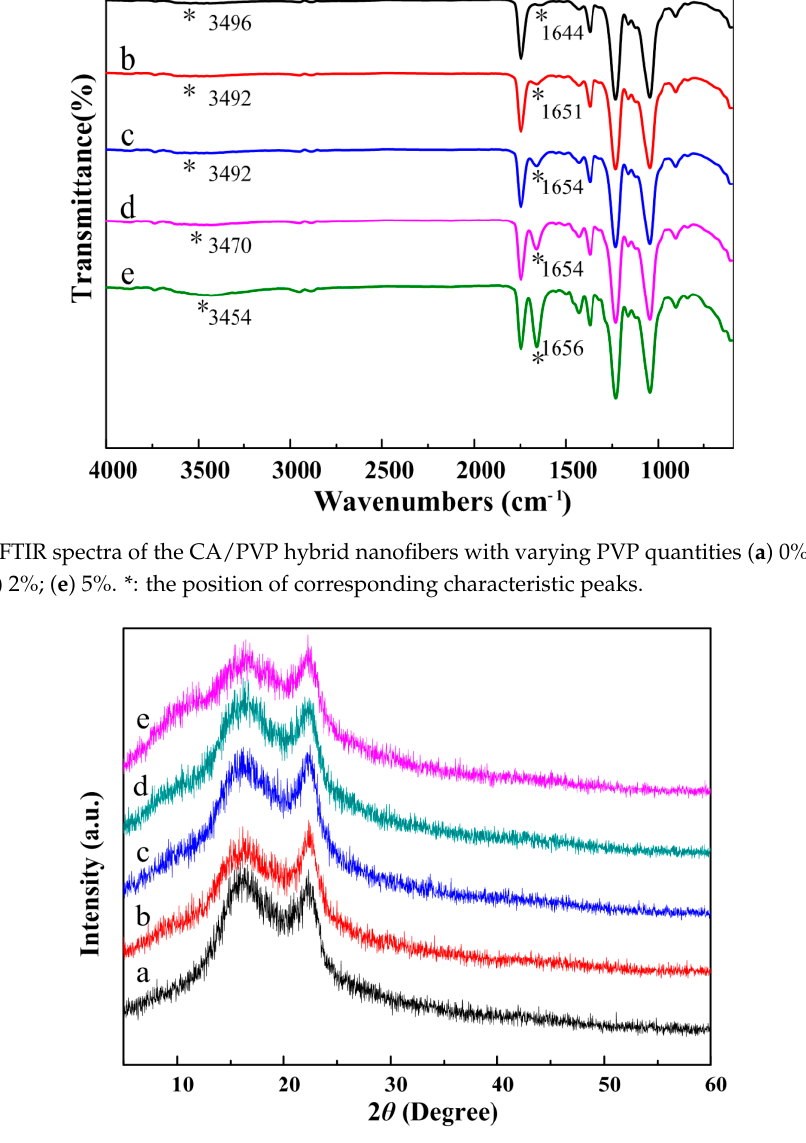
Figure 3. XRD patterns of the CA/PVP hybrid nanofibers with varying PVP quantities ( a ) 0%; ( b ) 0.5%; ( c ) 1%; ( d ) 2%; ( e ) 5%.